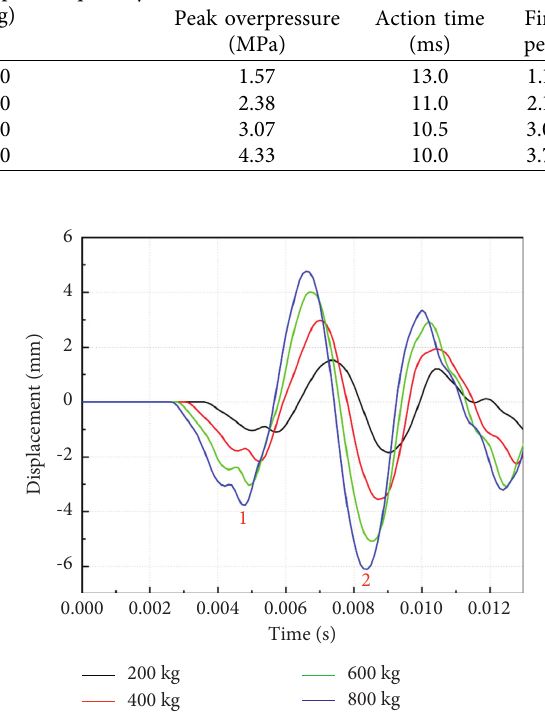
Table 7: Displacement, von Mises stress, and effective plastic strain of the EBD under the different explosive quantities. Explosive quantity